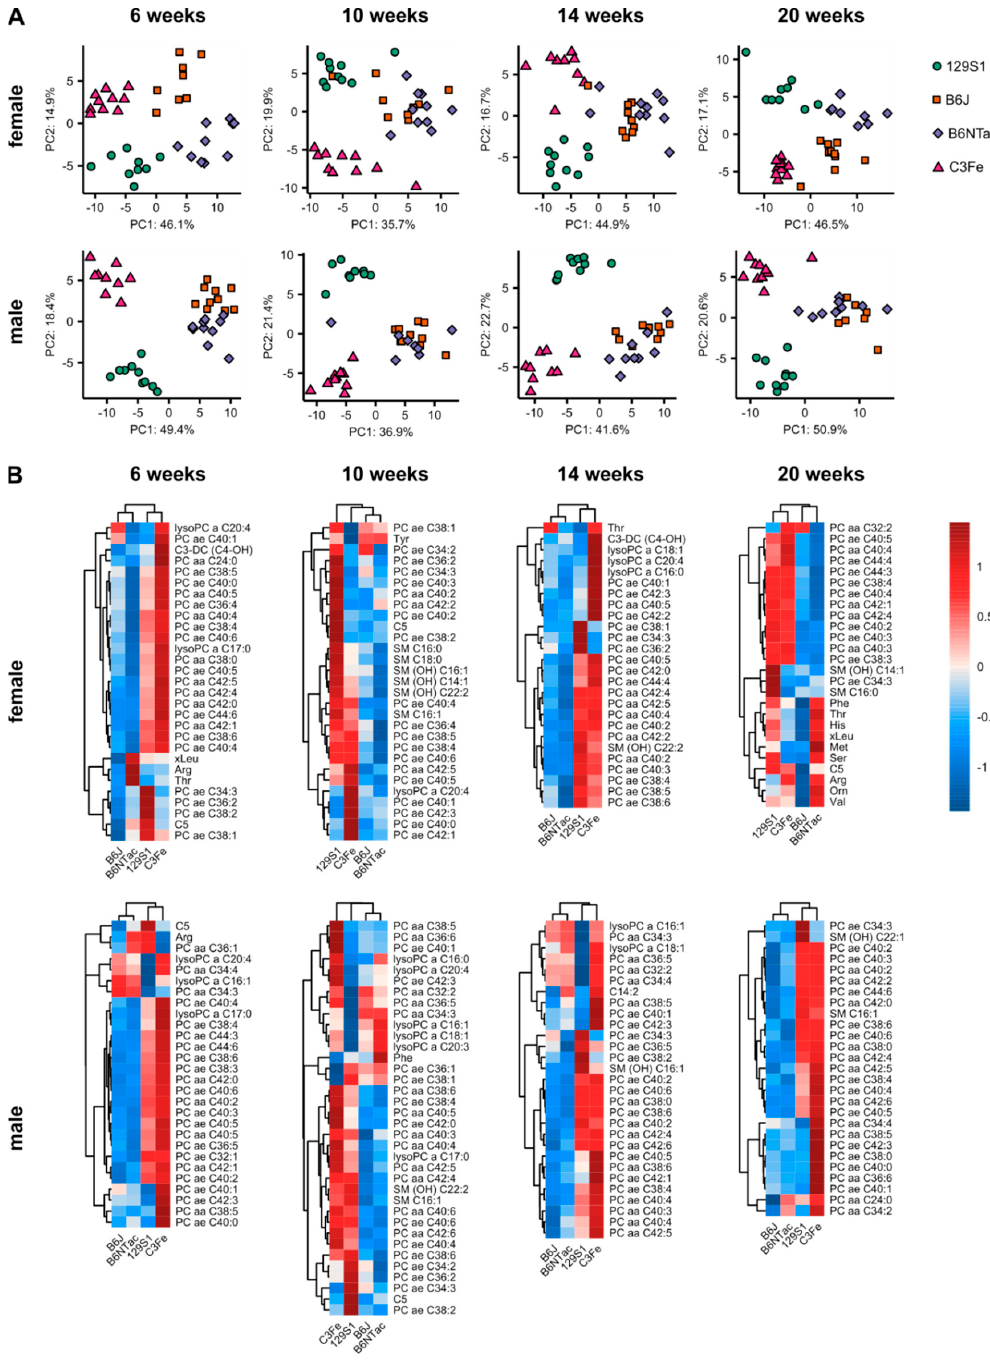
Figure 4. Differences in the plasma metabolome of age-matched mouse strains. ( A ) PCA of metabolomics data at the time points 6, 10, 14, and 20 weeks of age. ( B ) Heatmaps of z scores of top metabolites differentiating between strains at the different time points. Metabolites were selected based on loading scores of principle components 1 to 3 in PCA and the mean decrease in accuracy in random forest analysis. Z scores were calculated from scaled and centered mean metabolite concentrations.